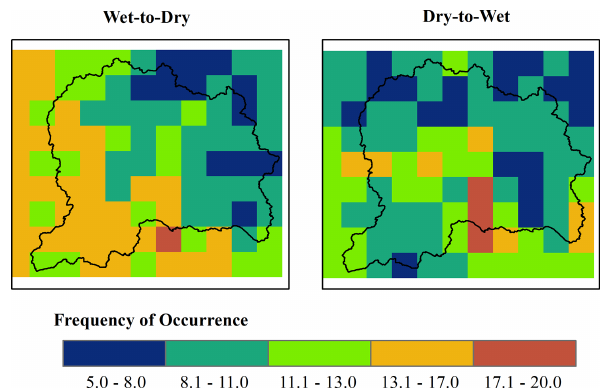
Figure 10. Frequency of occurrence of abrupt events, wet to dry (left) and dry to wet (right), during the period